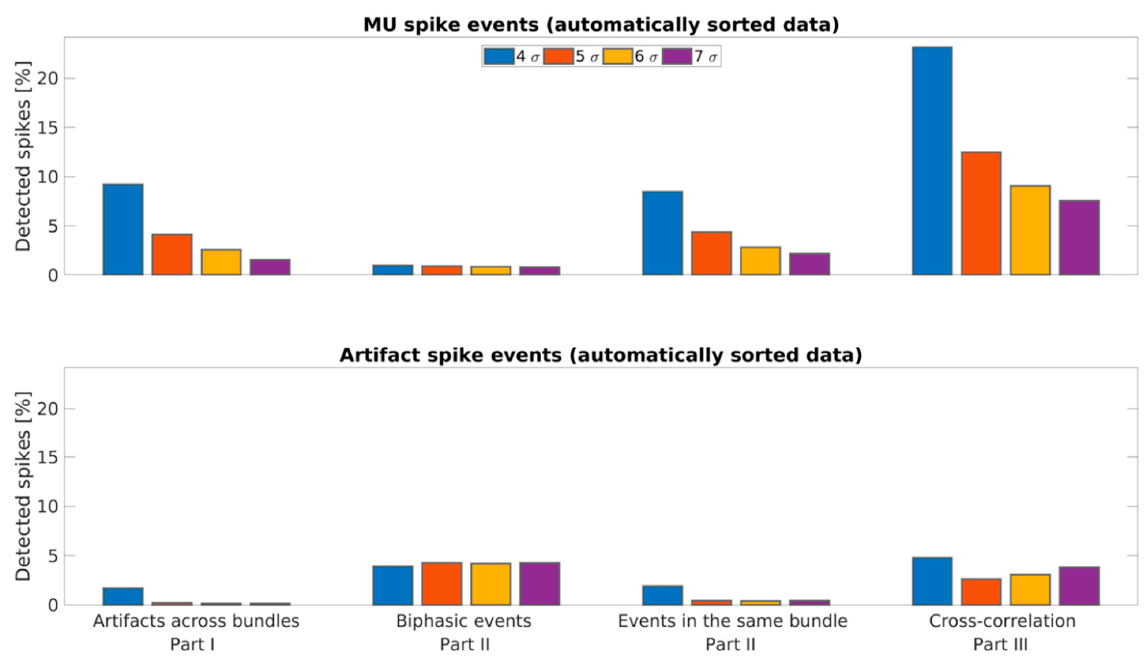
Figure A3. Performance of the DER algorithm for different spike-event extraction thresholds of Combinato on automatically clustered data. The percentage of detected spikes is shown for four different extraction thresholds in different colors (4 σ : blue, 50 million spike events; 5 σ : orange, 22 million spike events; 6 σ : yellow, 13 million spike events; 7 σ : purple, 9 million spike events), separately for multi-units and artifacts and for different parts of the DER algorithm. Table A1. Resources.